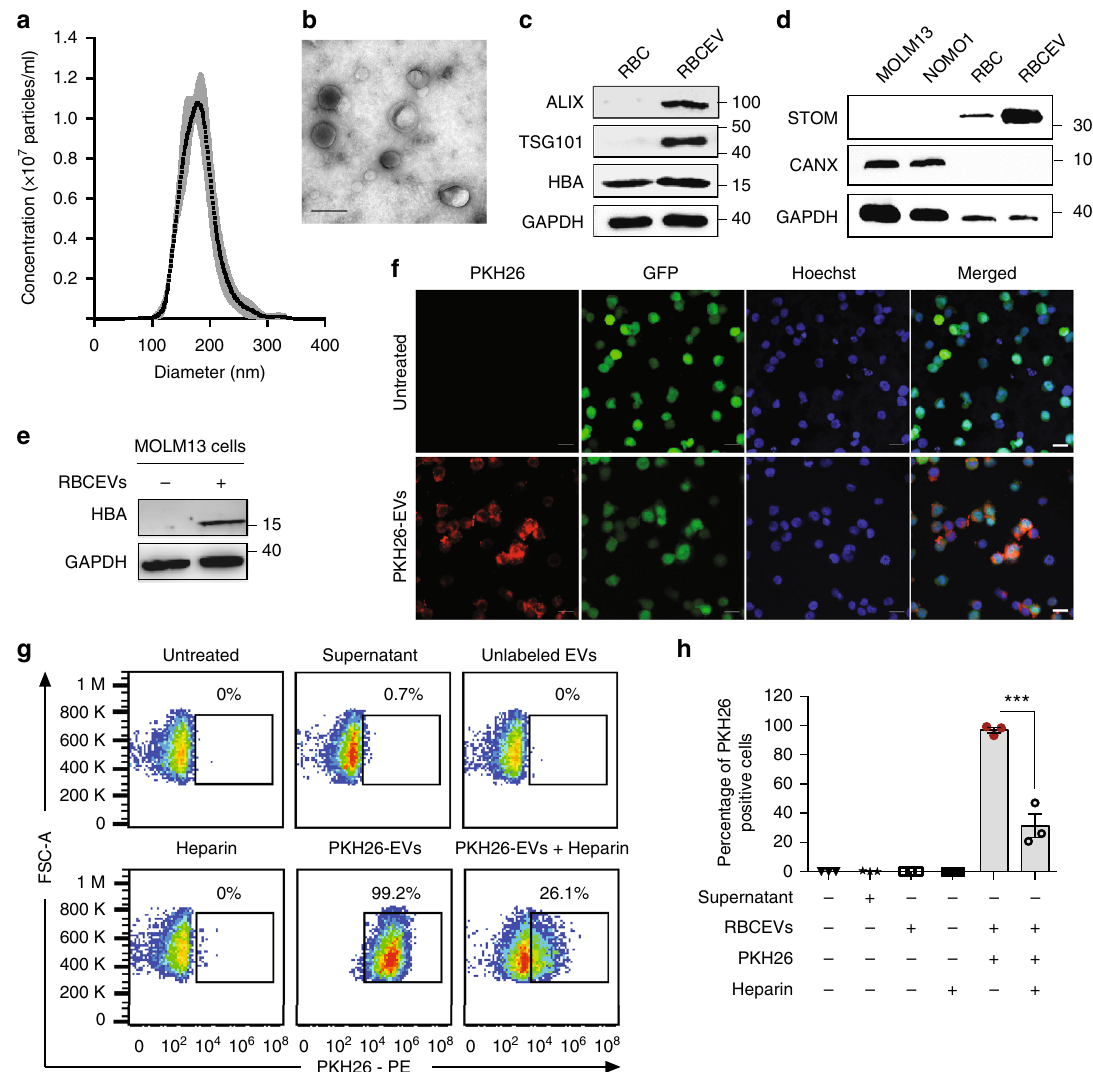
Fig. 1 Characterization of EVs from RBCs and uptake of RBCEVs by leukemia cells. a Average concentrations (100,000× dilution) of RBCEVs from three donors ± SEM (gray) and their size distribution, determined using a Nanosight nanoparticle analyzer. b Representative transmission electron microscopy image of RBCEVs. Scale bar: 100 nm. c Western blot analysis of EV markers ALIX and TSG101; and RBC marker Hemoglobin A (HBA) relative to GAPDH (loading control) in cell lysates and EVs from RBCs. d Western blot analysis of Stomatin (STOM) and Calnexin (CANX) as the markers of RBCEVs and endoplasmic reticulum, respectively, relative to GAPDH, in leukemia MOLM13 cells, NOMO1 cells, RBCs, and RBCEVs. e Western blot analysis of HBA relative to GAPDH in leukemia MOLM13 cells untreated or incubated with 8.25 × 10 11 RBCEVs for 24 h. f Representative immuno fl uorescent images of MOLM13-GFP cells incubated with 12.4 × 10 11 PKH26-labeled EVs for 24 h. Scale bar, 20 µ m. g FACS analysis of PKH26 in MOLM13 cells that were incubated with 12.4 × 10 11 unlabeled or PKH26-labeled EVs with and without Heparin for 24 h. The supernatant of the last wash after PKH26 labeling was used to determine the background. Percentages of PKH26-positive cells are indicated above the gates. h Average percentage of PKH26-positive cells in each condition (mean ± SEM, n = 3 cell passages). P value (*** P < 0.001) was determined using Student ’ s one-tail t -test. In c – e , molecular weights (KDa) of protein markers are shown on the right. Each experiment was repeated two to three times in 2 – 3 cell